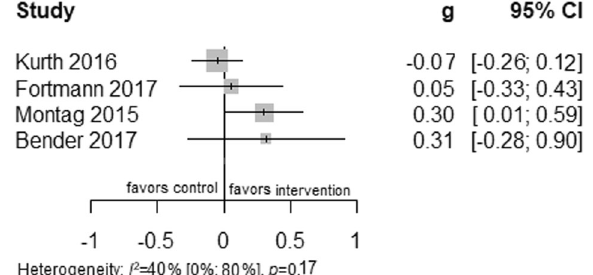
Fig. 4 Summary of culturally adapted IMI of health promotion vs. active controls in the short-term. A summary plot of effect sizes of four studies of culturally adapted IMI of health promotion vs. active controls in short-term are presented.